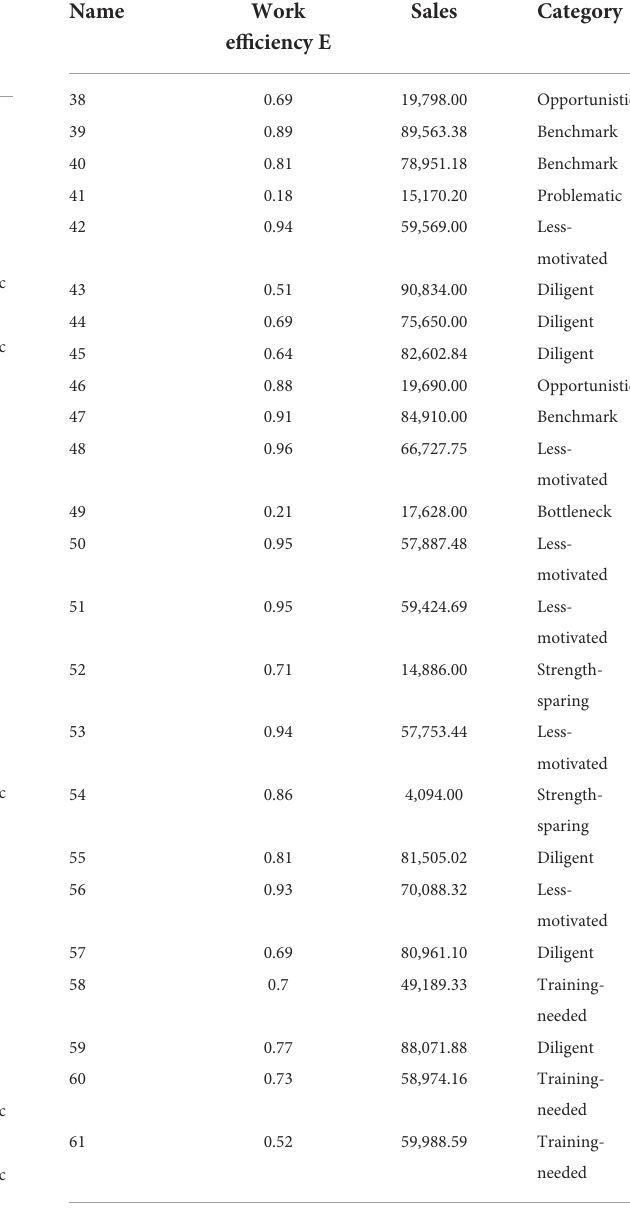
TABLE 3 Salesperson performance classification based on integrated DEA with Gini